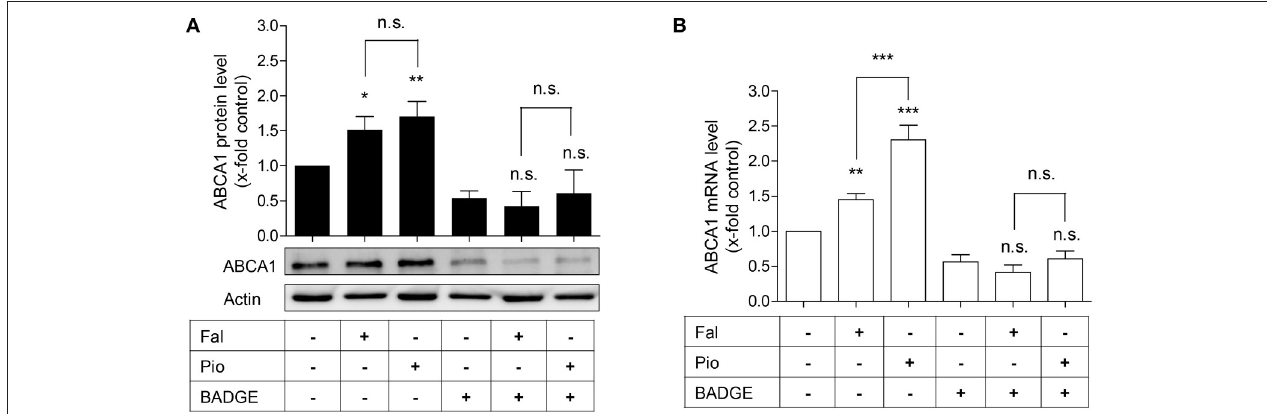
FIGURE 3 | The PPAR γ antagonist, BADGE, blocks falcarindiol-mediated ABCA1 protein and mRNA induction. Differentiated THP-1 macrophages were incubated for 24h with falcarindiol (Fal, 10 µ M) or pioglitazone (Pio, 10 µ M) with or without 50 µ M BADGE. ABCA1 protein (A) and mRNA (B) level were analyzed by western blotting and qPCR, respectively. All data are mean ± SD ( n = 3), * p < 0.05, ** p < 0.01, *** p < 0.001, n.s. not significant vs. solvent vehicle control (DMSO) (ANOVA/Bonferroni).